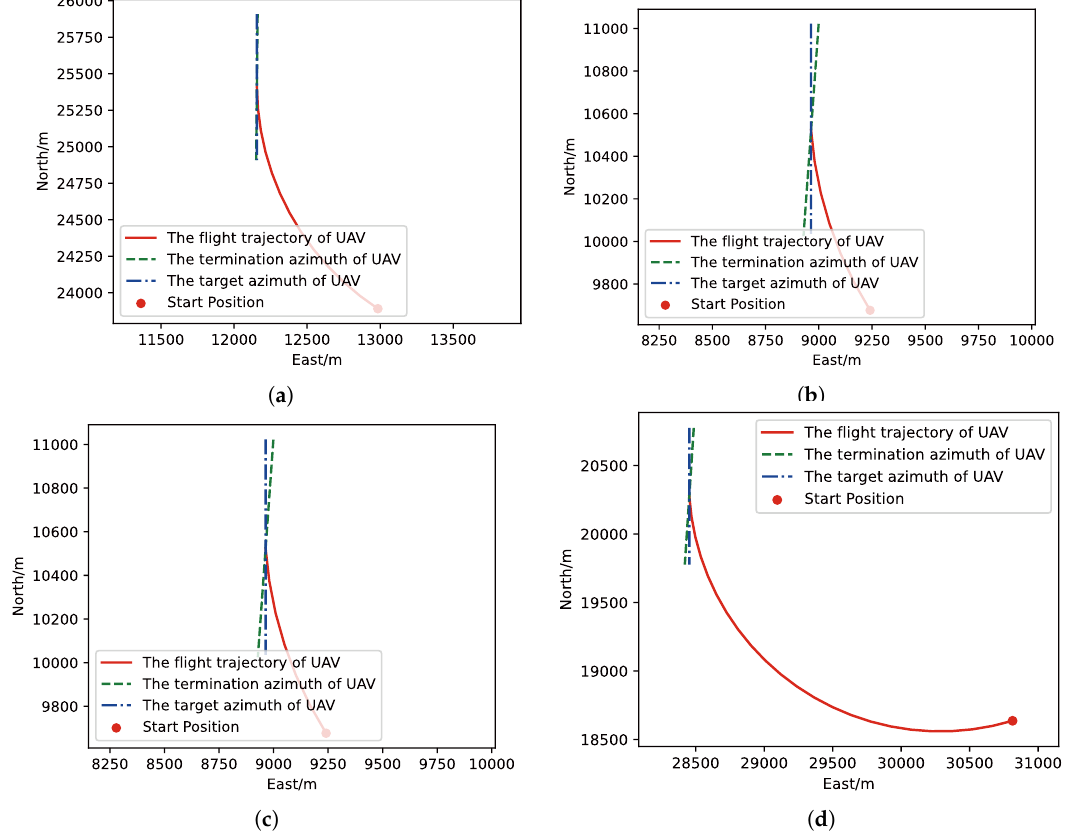
Figure 10. The flight trajectory from Monte-Carlo (MC) experiments for the trained result of UER-DDPG: ( a ) the flight trajectory of 1st experiment; ( b ) the flight trajectory of 2nd experiment; ( c ) the flight trajectory of 3rd experiment; ( d ) the flight trajectory of 4th